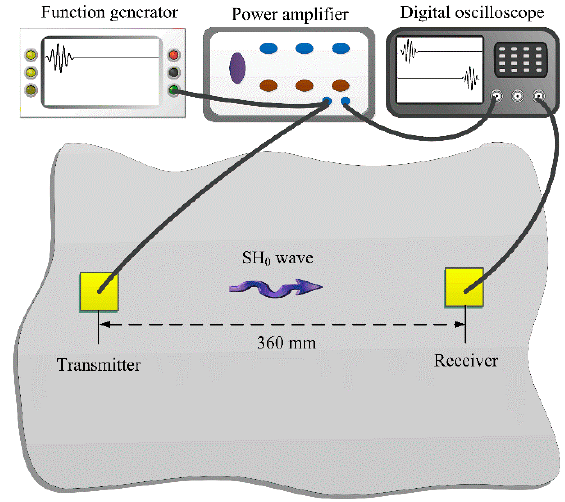
Figure 4. The schematic of experimental setup.